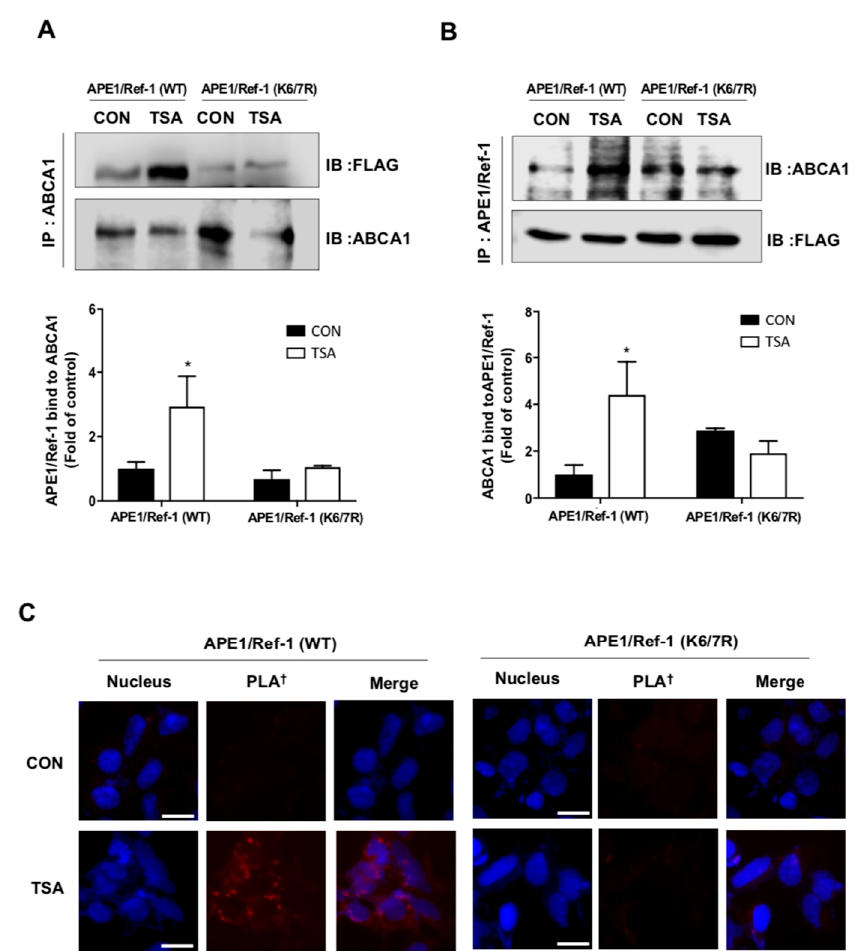
Figure 4. Plasma membrane associated APE1 / Ref-1 is bound to ABCA1 in response to acetylation. Cells transiently expressing wild type APE1 / Ref-1-FLAG or mutant APE1 / Ref-1(K6 / 7R)-FLAG were treated with 1 µ M TSA for 1 h. ( A ) Whole cell lysates were immunoprecipitated using the monoclonal anti-ABCA1 antibody, followed by immunoblot with the anti-FLAG antibody. ( B ) For reverse immunoprecipitation, cell lysates were immunoprecipitated with anti-APE1 / Ref-1 antibody followed by immunoblot analysis with the polyclonal anti-ABCA1 antibody. Blots were stripped and re-probed with anti-ABCA1 or FLAG antibodies to ensure equal protein loading and no contamination of cellular proteins. Similar results were observed in replicate experiments. Columns , mean ( n = 2-3); bars , SE. *, p < 0.05 indicates a significantly di ff erent result from control cells according to unpaired t- tests. ( C ) The binding between APE1 / Ref-1 and ABCA1 in the plasma membrane was visualized using with a Duolink II PLA system with primary polyclonal anti-APE1 / Ref-1 and monoclonal anti-ABCA1 antibodies (PLA † ). The PLA-specific fluorescence which represents the APE1 / Ref-1-ABCA1 signal, and the DAPI nuclear staining are in red and blue, respectively. The experiment was repeated multiple times with similar results; the data shown here are from a representative experiment. Optical slices were examined using a 40 × oil immersion objective with a 2 × zoom factor. Scale bar, 20 µ m ( ×